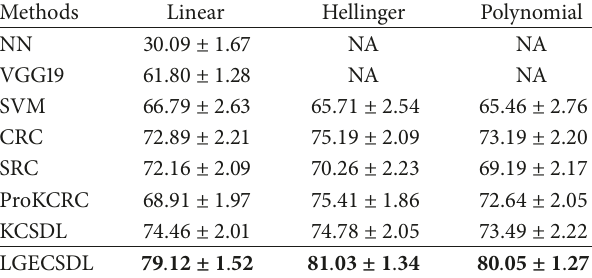
Table 3: Recognition rate on the CMU-PIE database (%).